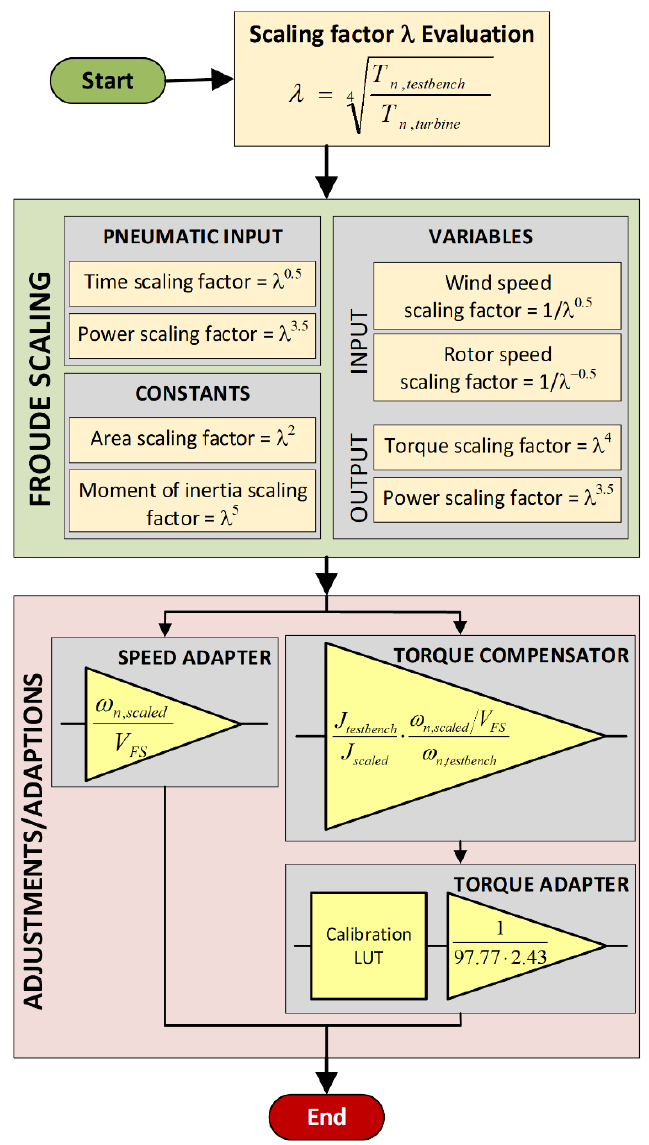
Figure 11. Scheme of the methodology for scaling, compensations, and adaptations that must be applied to the original model for the two-chambers OWC here considered.